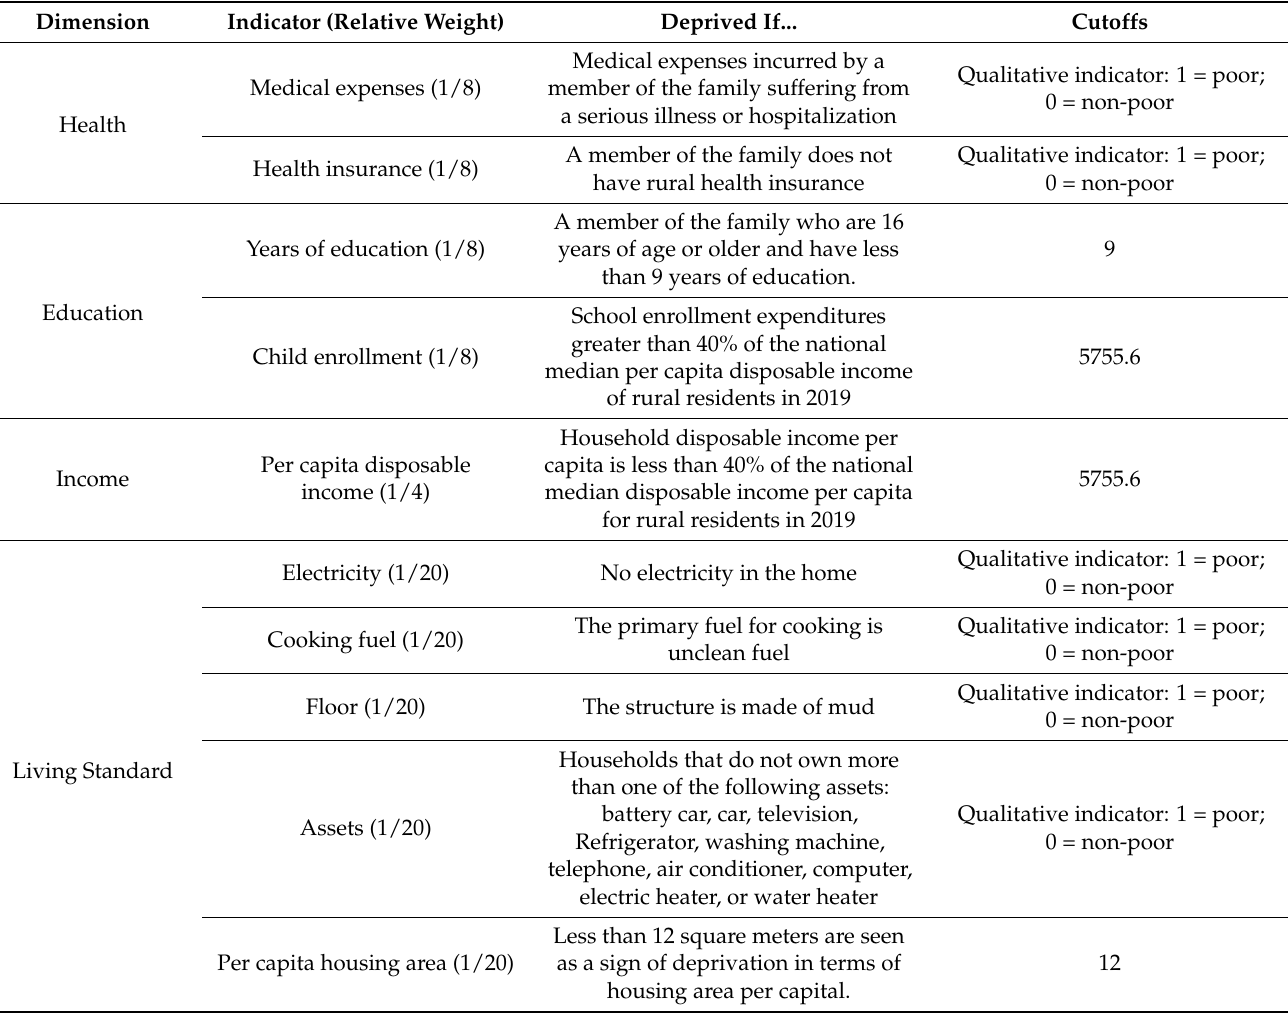
Table 1. Dimensions, indicators, cutoffs, and weights of the